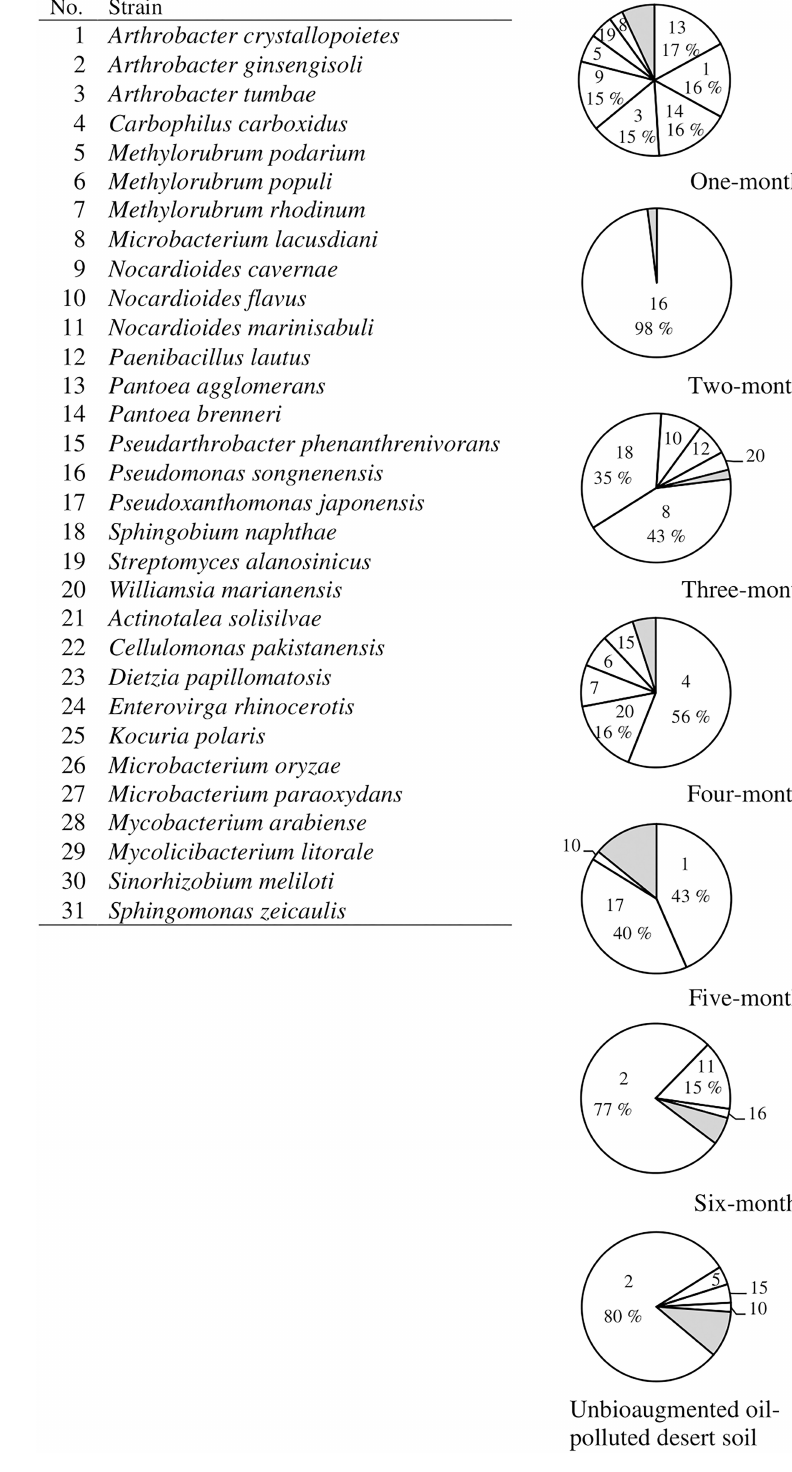
FIGURE2 Dynamics of hydrocarbonoclastic microbial communities in the unbioaugmented and bioaugmented oil-polluted desert soil. Shaded areas comprise minor organisms (1–2% occurrence), refer to Supplementary Table S3 for their